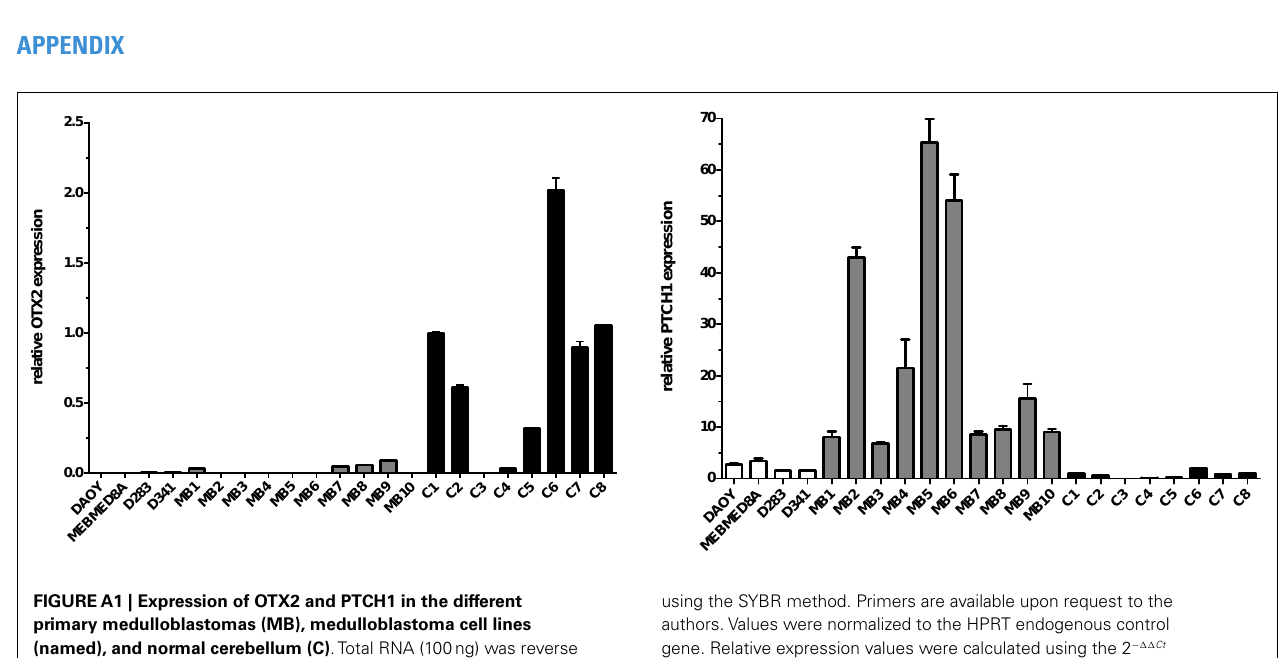
FIGUREA1 | Expression of OTX2 and PTCH1 in the different primary medulloblastomas (MB), medulloblastoma cell lines (named), and normal cerebellum (C) .Total RNA (100ng) was reverse transcribed and gene expression was measured by qPCR, in triplicates,